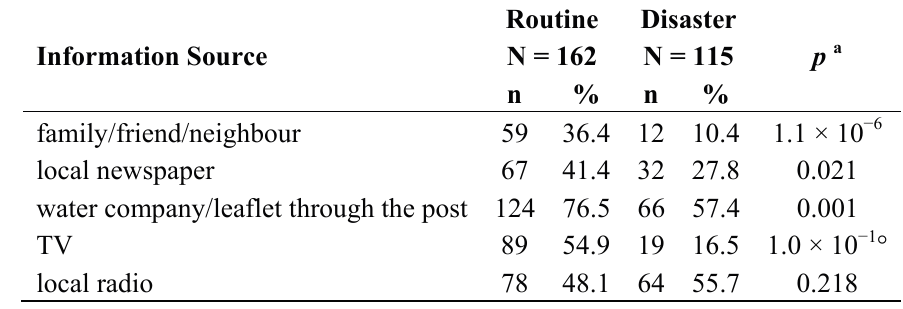
Table 2. Use of information sources by routine incident and natural disaster respondents.